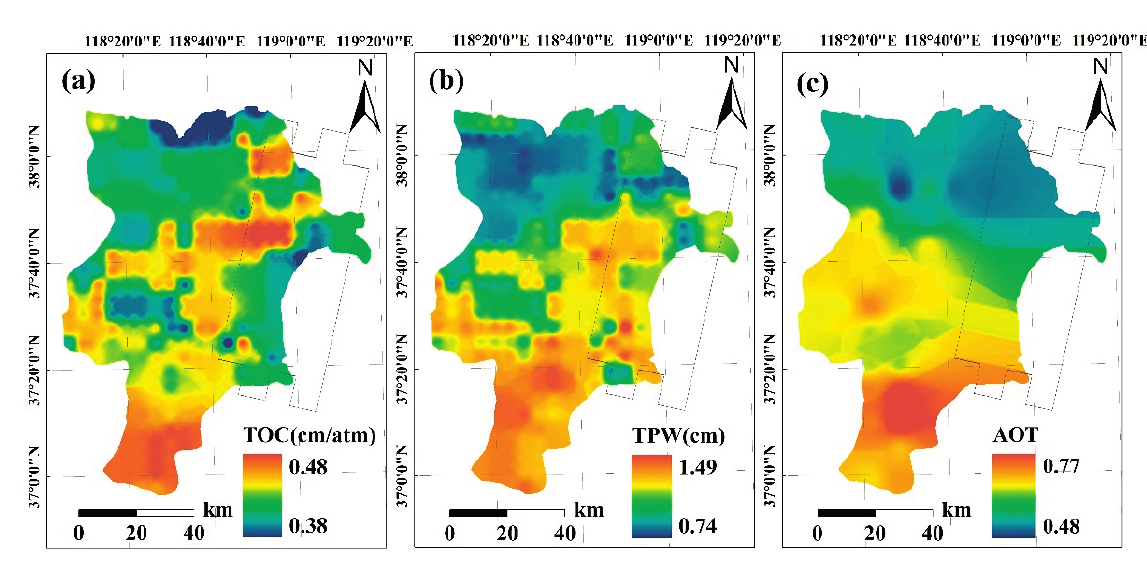
Figure 6. Spatial distribution of ozone concentration ( a ); water vapor content ( b ) and aerosol optical thickness at 550 nm ( c ) within the Yellow River Delta. The 30 m-resolution values were interpolated from MODIS atmosphere